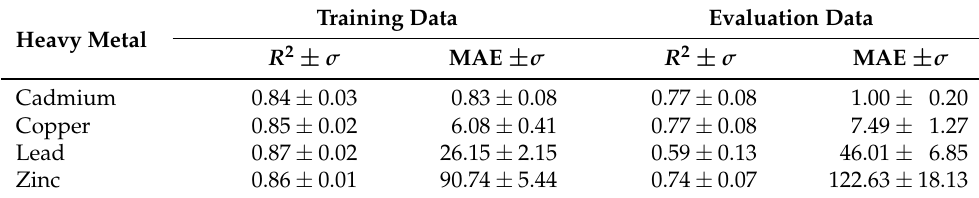
Table 4. Standalone prediction model via Gaussian process.